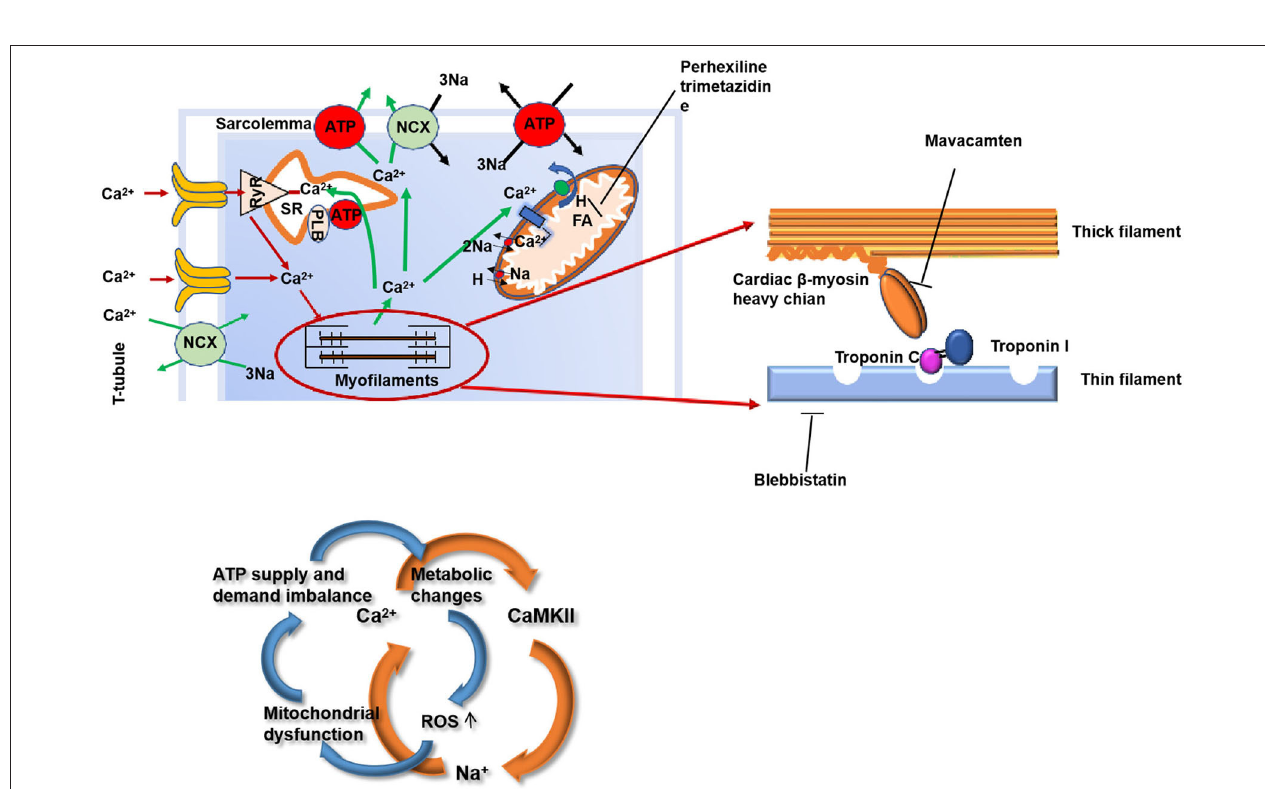
FIGURE 2 | The structure of the myocardium and the mechanism of myocardial contraction are the potential targets for HCM therapy. HCM, hypertrophic cardiomyopathy; RyR, ryanodine receptor; SR, sarcoplasmic reticulum; NCX, sodium/calcium exchange pump; PLB, phospholamban; ROS, reactive oxygen species; FA, fatty